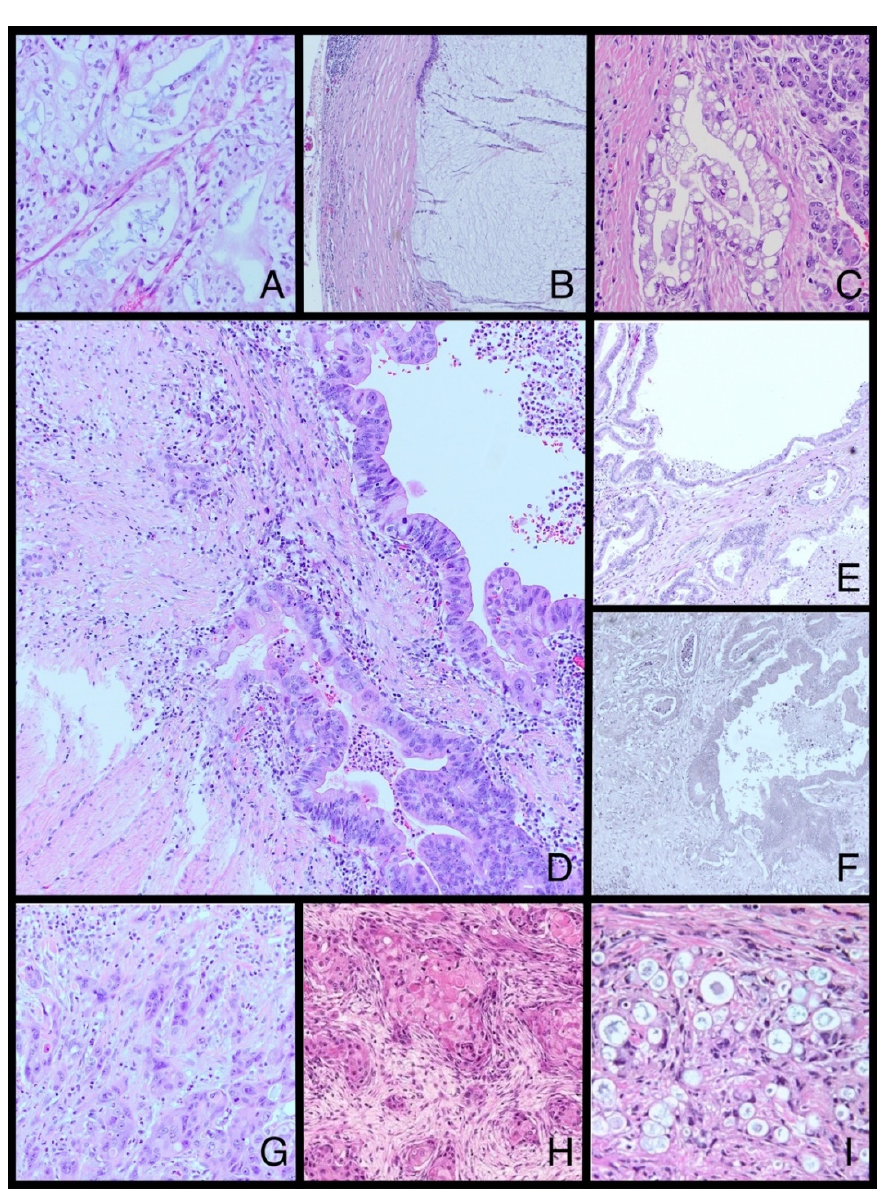
Figure 2. Selected WHO and non-WHO morphological subtypes of PDAC: ( A )—clear cell subtype, ( B )—colloid subtype, ( C )—foamy gland pattern, ( D )—PDAC derived from IPMN, invasive compo- nent, ( E )—large duct/cystic papillary pattern, ( F )—large duct/cystic papillary pattern negative for elastic stain, ( G )—high-grade squamous differentiation, ( H )—low-grade squamous differentiation— reproduced with permission from Kalimuthu et al., Gut, published by BMJ, 2020 [17], ( I )—vacuolated cell pattern—reproduced with permission from Samad et al., Diagnostic Cytopathology, published by Wiley Periodicals, Inc., 2014 [79]; PDAC, pancreatic ductal adenocarcinoma; IPMN, intraductal papillary mucinous neoplasm; ( A – F ) orcein stain; original magnification ( A , C , D , G – I ) 100×, ( B , E , F ) 40×.